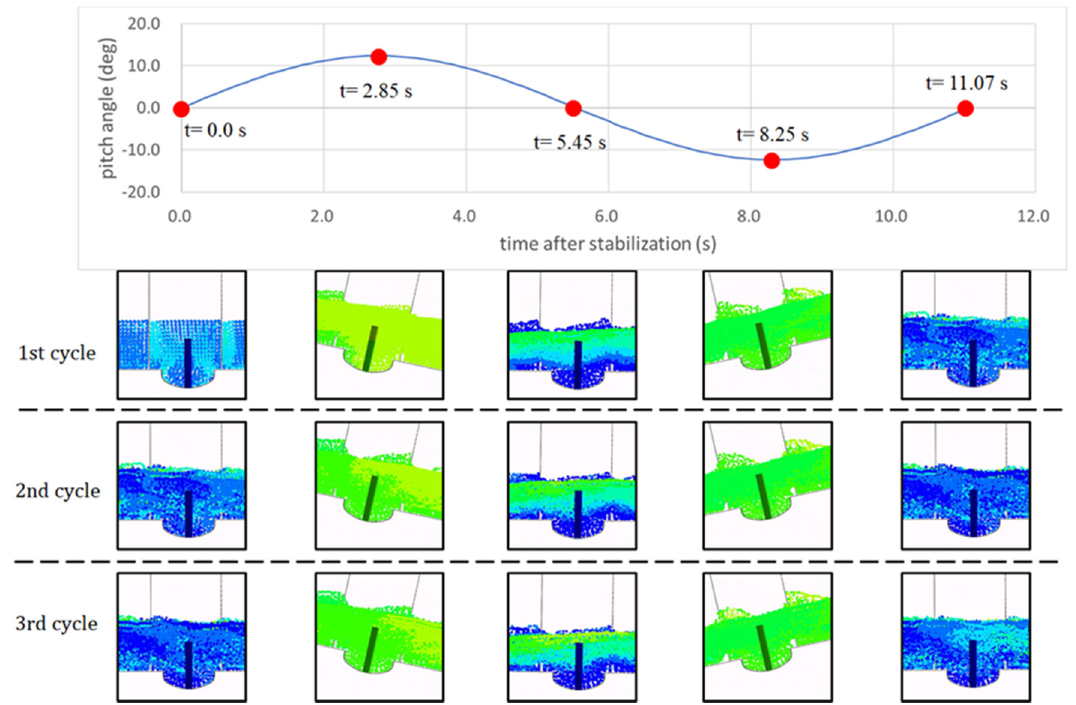
Figure 10. Snapshots of Model 4 under pitching conditions.